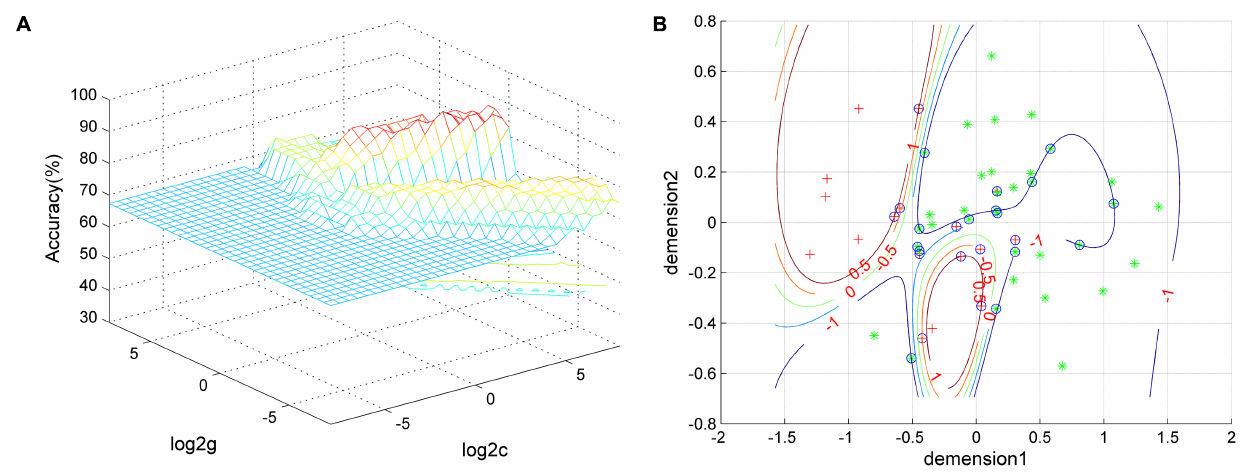
FIGURE 6 | The visualization of SVM classification using the combination of the PAS scores of the left IFG and left superior MPFC. (A) SVM parameter result of 3D view and (B) classified map of the results. Green asterisks represent the GI-MDD patients, and red crosses represent nGI-MDD patients. GI-MDD, major depressive disorder with gastrointestinal symptoms; IFG, inferior frontal gyrus; MPFC, medial prefrontal cortex; nGI-MDD, major depressive disorder without gastrointestinal symptoms; PAS, parameter of asymmetry; SVM, support vector